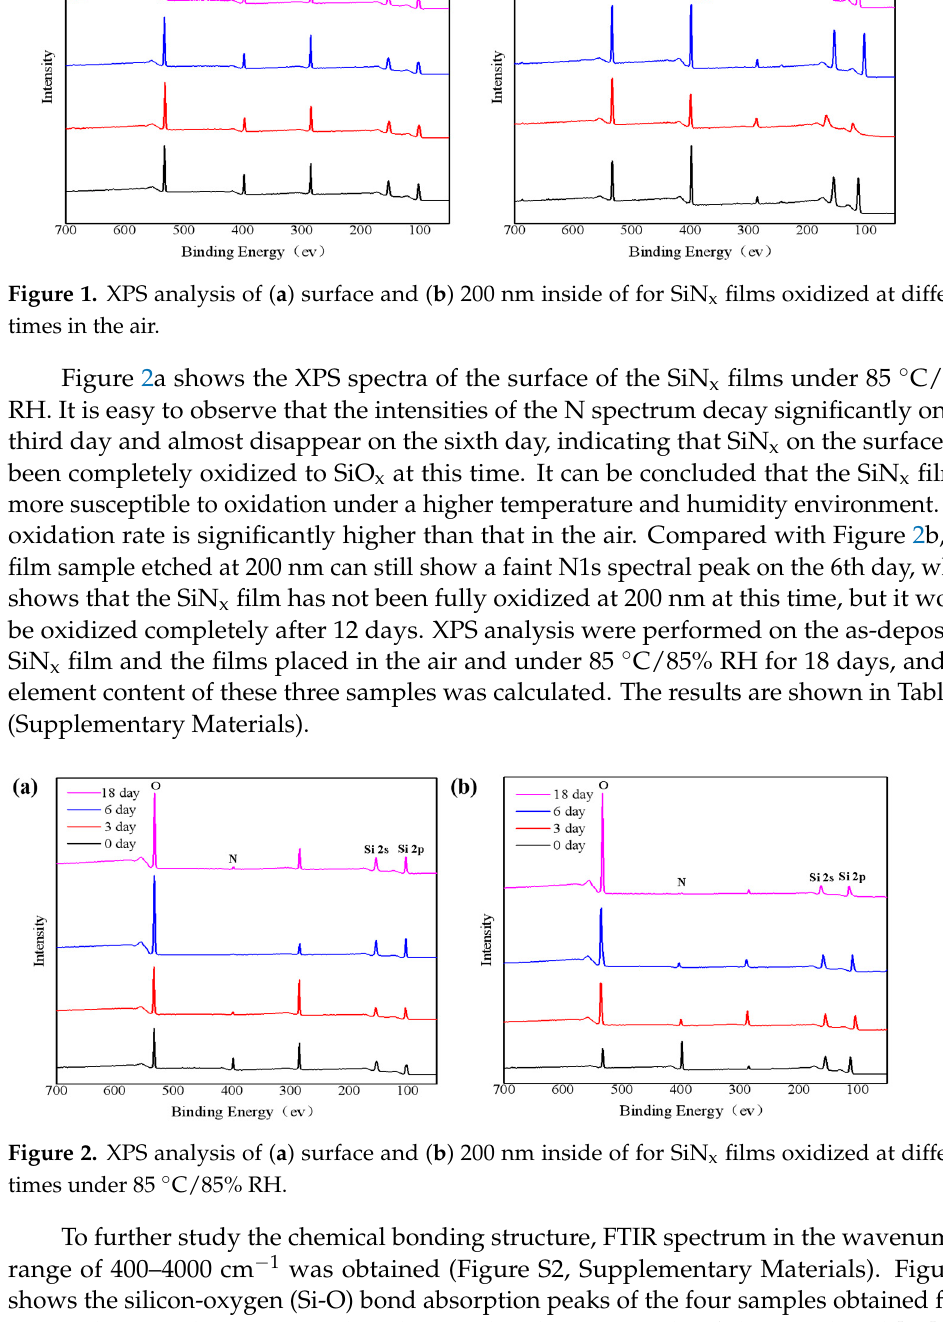
Figure 1. XPS analysis of ( a ) surface and ( b ) 200 nm inside of for SiN x films oxidized at different times in the air.